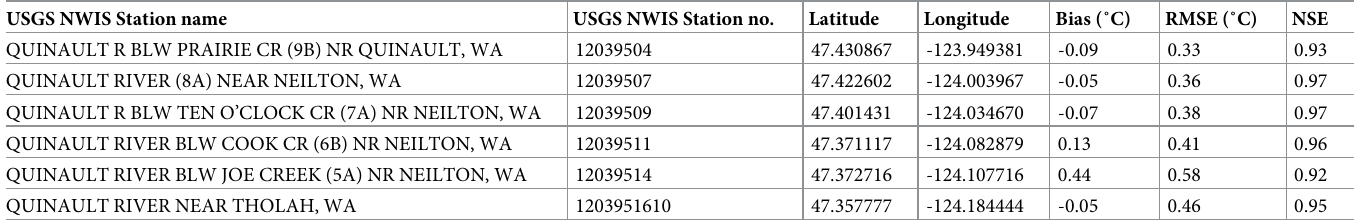
Table 4. Measures of calibrated water temperature daily model fit by continuous monitoring location. USGS NWIS Station name